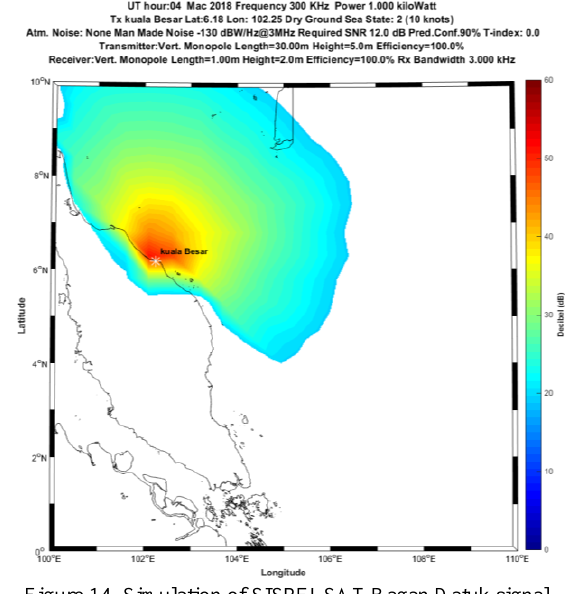
Figure 14. Simulation of SISPELSAT Bagan Datuk signal Figure 13. Simulation of SISPELSAT Bagan Datuk signal coverage showing